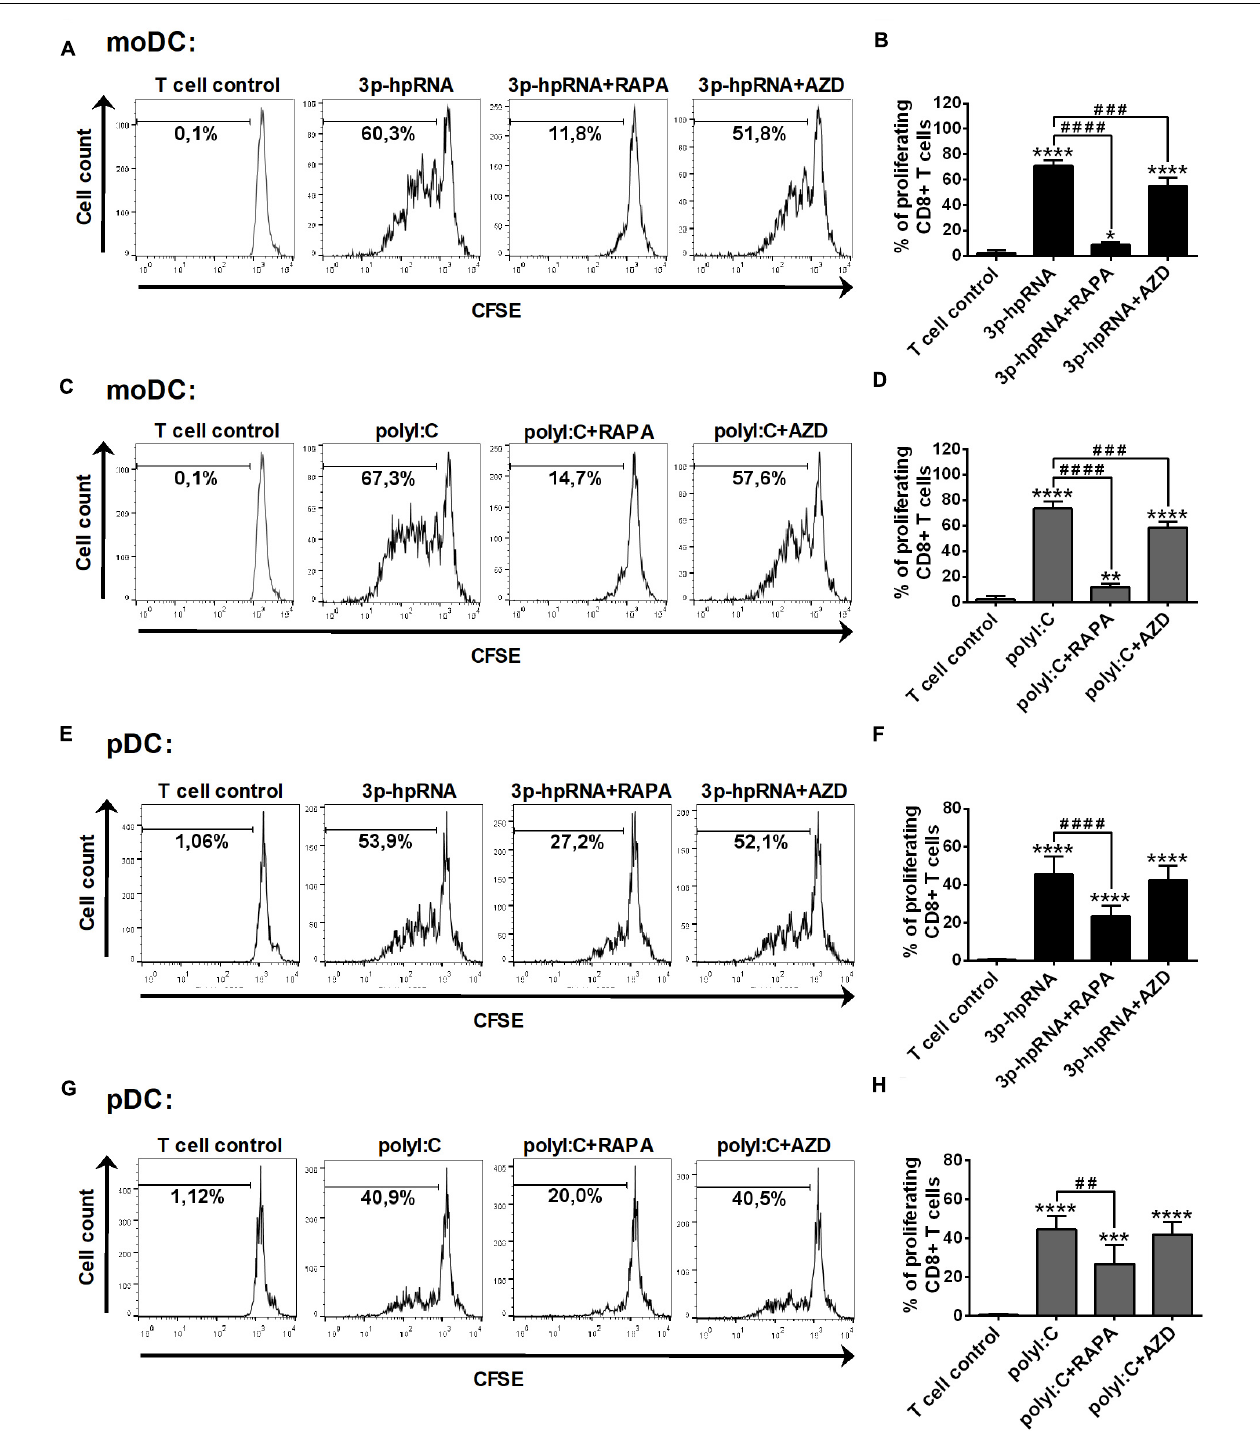
FIGURE 9 | Rapamycin but not AZD8055 effectively inhibits the ability of RLR-stimulated moDCs and primary pDCs to induce proliferation of naive T cells. CFSE-labeled naïve CD8 + T cells were co-cultured with allogeneic moDCs (A–D) and primary pDCs (E–H) pre-treated with the indicated reagents. After 5 days of co-cultivation, cell division was measured by flow cytometry. (A,C,E,G) Representative histograms are shown where numbers indicate the percentage of viable dividing T cells. In A and C T cell controls are the same, since representative dot plots originate from the same set of experiment from one single donor. (B,D,F,H) Bar graphs represent the mean ± SD of at least 6 independent experiments. * p < 0.05, ** p < 0.01, **** p < 0.0001 vs. control; ### p < 0.001, #### p < 0.0001. AZD: AZD8055, RAPA: rapamycin.